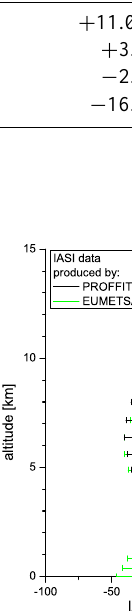
Table 4. Relative differences (bias and scatter) between our IASI PROFFIT, EUMETSAT’s IASI, and the coincident RS92 H 2 O data sets (mean ± std of 2 × X − Y ) [%]. X + Y